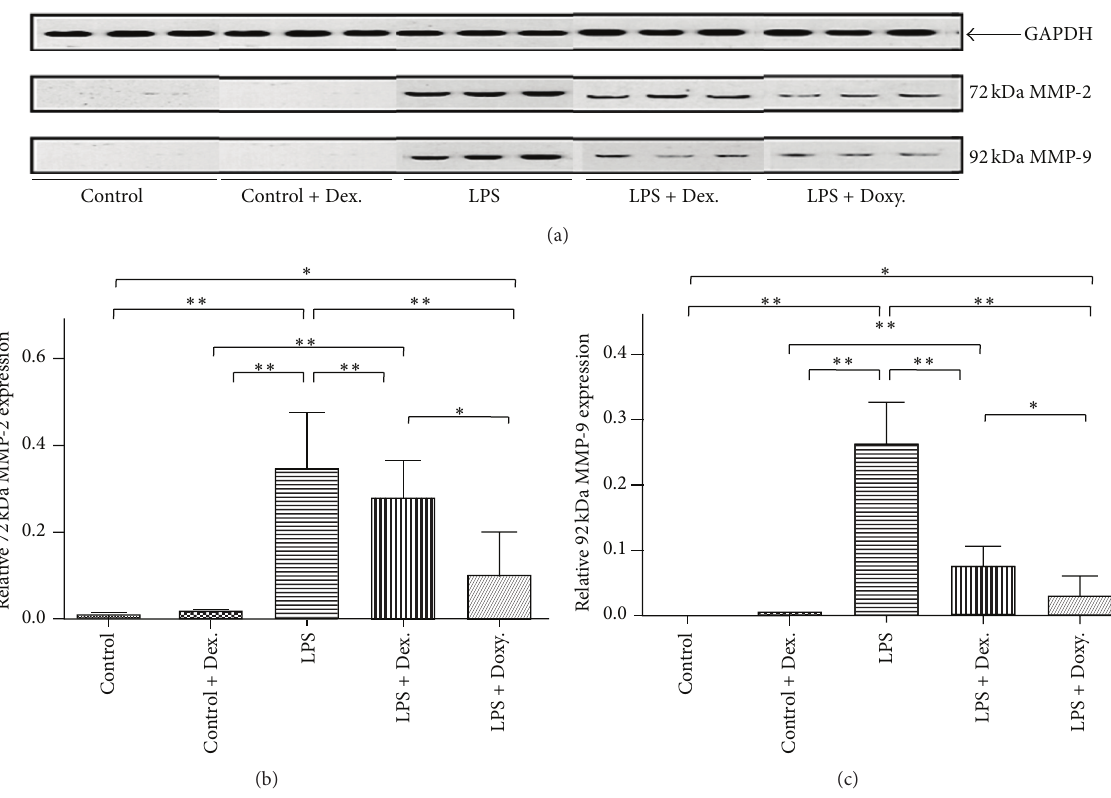
Figure 3: Immunoblotting of MMP-2 and MMP-9. Proteins were extracted from the aortic tissues of indicated treatment groups and immunoblotted for MMP-2 and MMP-9 as described in the method. (a) Immunoblotting image of MMP-2 and MMP-9 among different groups. GAPDH was used as loading control. Latent MMP-2 (72kDa) and MMP-9 (92-kDa) were detected as indicated. (b and c) Densitometric analysis of 8 biological replicates of MMP-2 and MMP-9, respectively. ∗ 𝑝 < 0.05 ; ∗∗ 𝑝 < 0.001